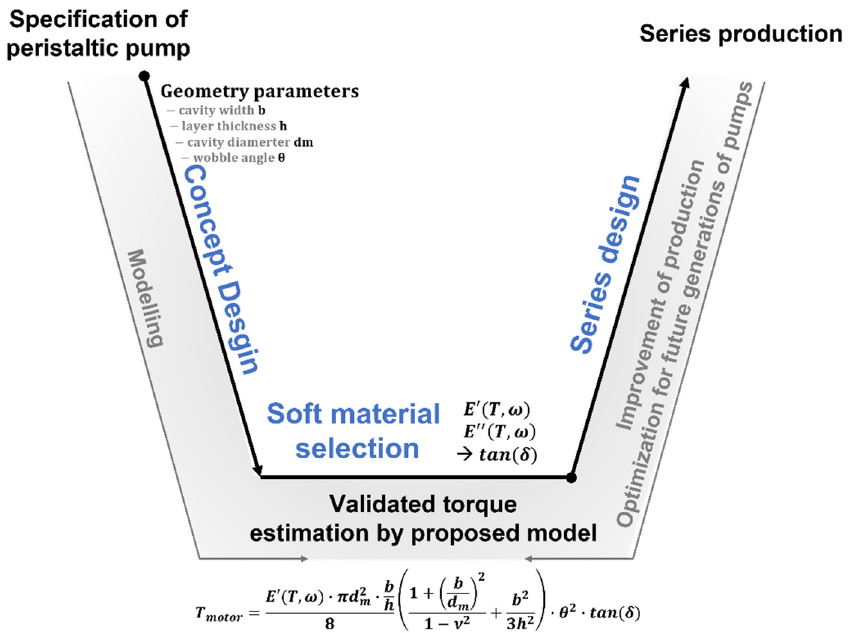
Figure 32. V-model of the evaluated design methodology.